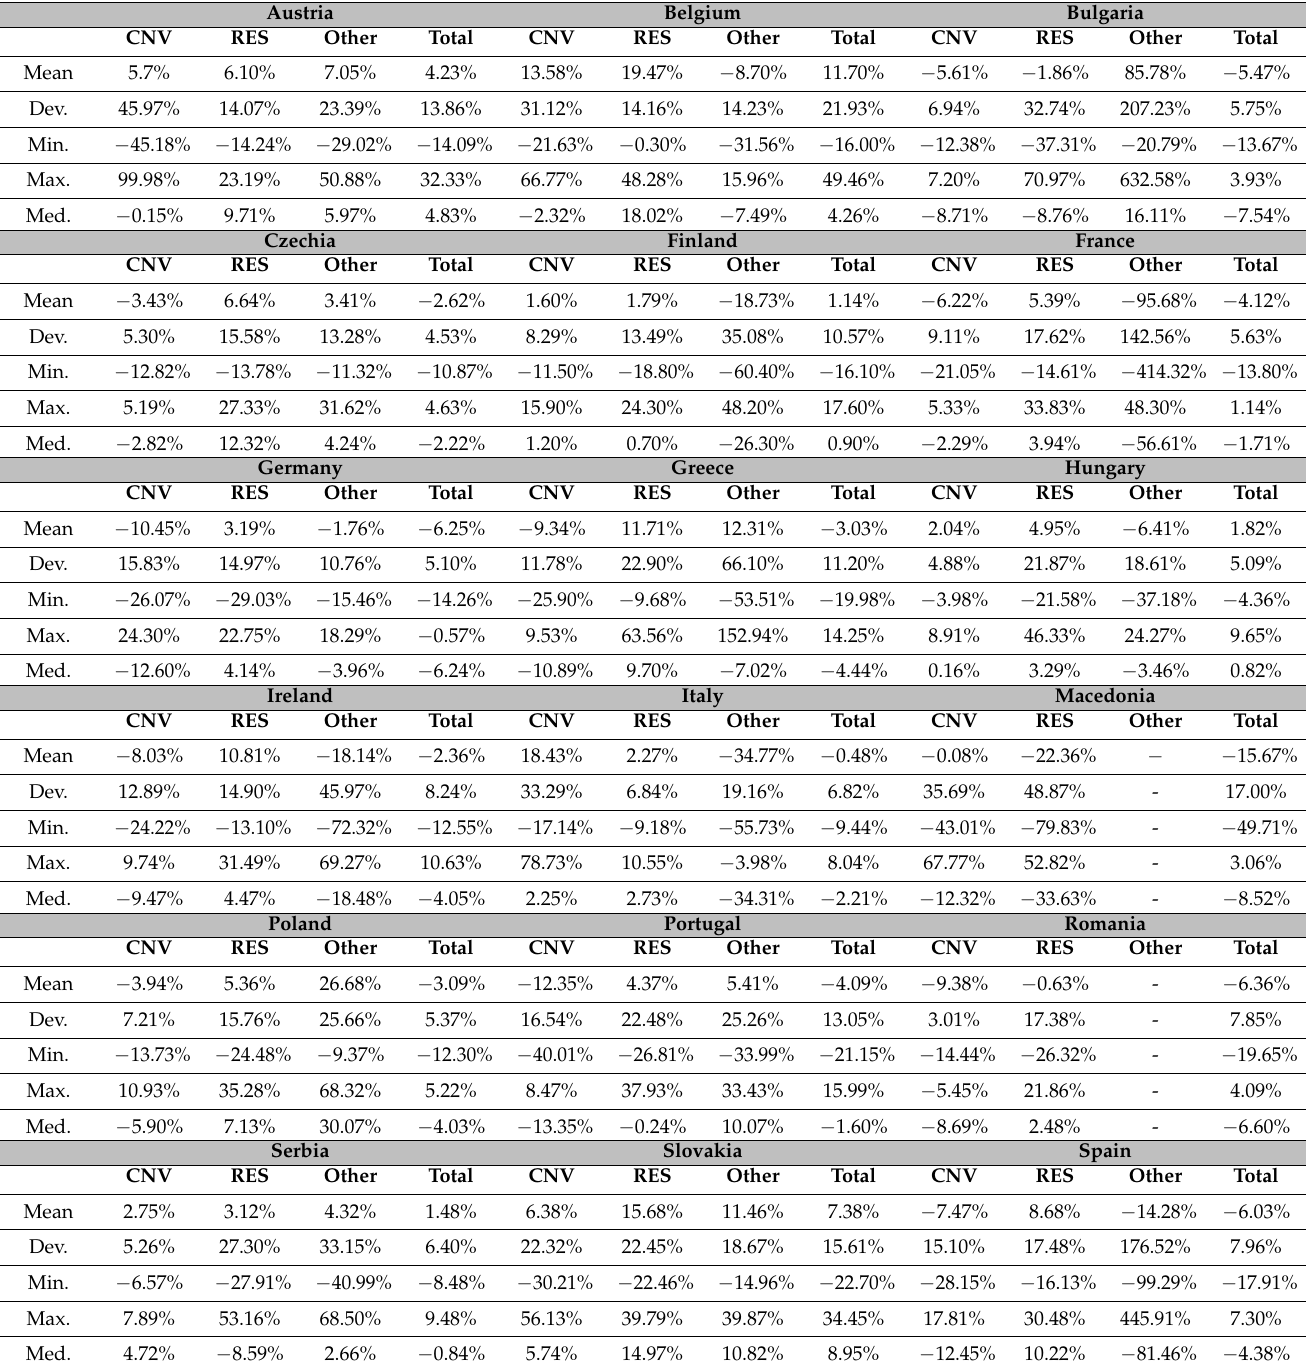
Table 2. Descriptive statistics for the data. Source: own calculations on the basis of